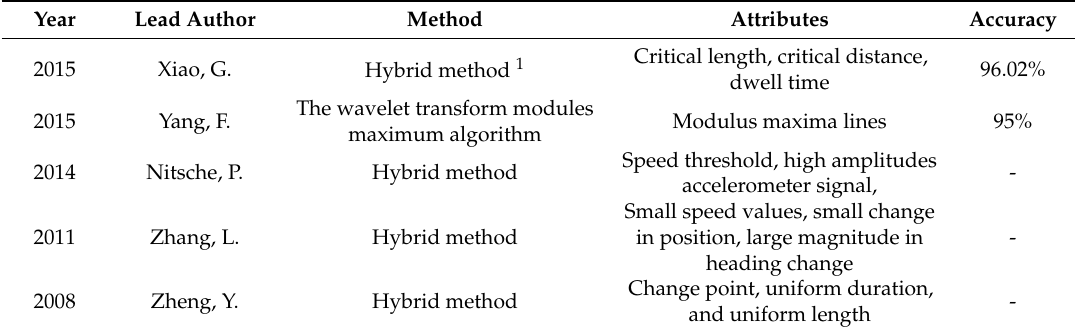
Table 4. Summary of records’ parameters used for TI/SI in selected